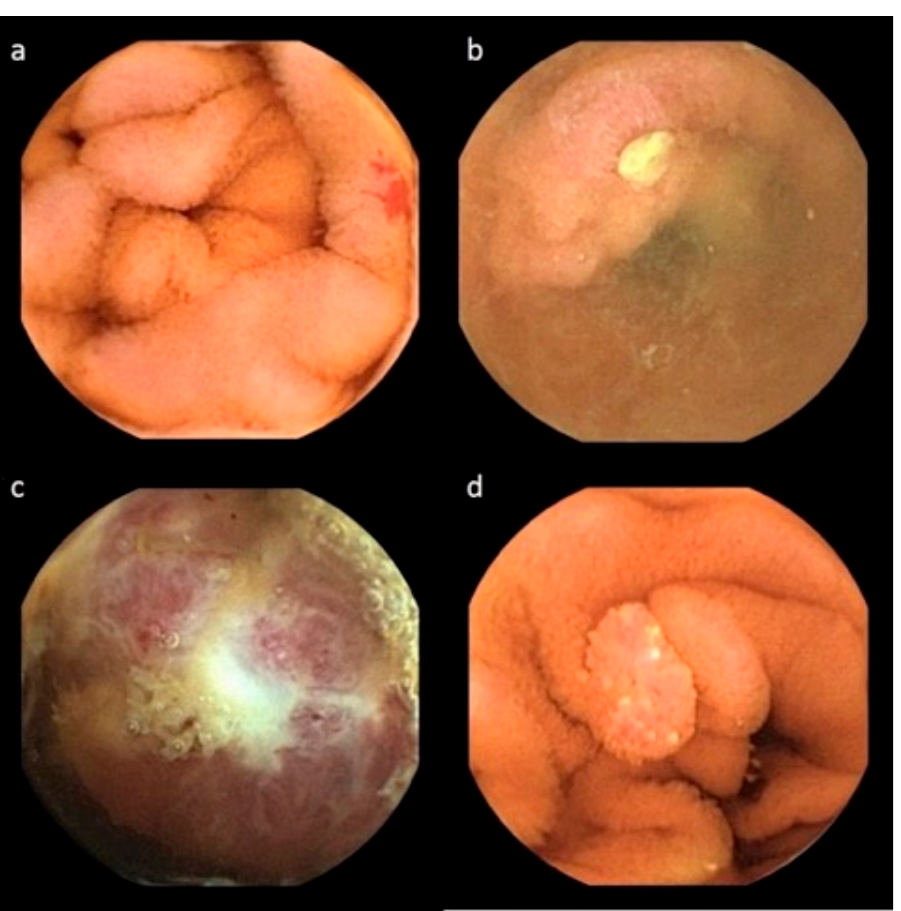
Figure 2. Capsule endoscopy findings. ( a ) Jejunal angiodysplasia; ( b ) ileal ulcer; ( c ) jejunal tumor; ( d ) jejunal polyp. Table 4. Diagnostic accuracy of readers in EV mode and SR when both are compared to consensus